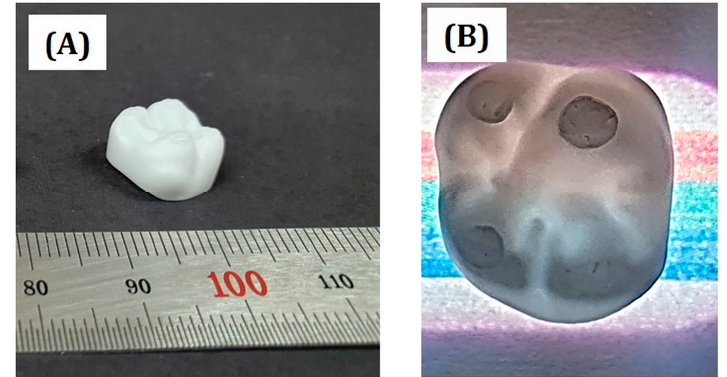
Figure 15. Optical images showing ( A ) 3D shape of a 4Y-PSZ dental crown sintered at 1500 ◦ C for 3 h and ( B ) its translucency placed onto colored lines under light illumination.